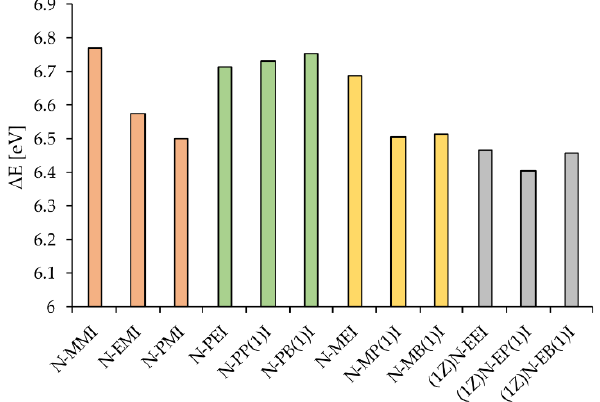
∆ E values of investigated aliphatic Schiff bases in gas Figure 3. ΔE values of investigated aliphatic Schiff bases in gas phase . Figure 3.